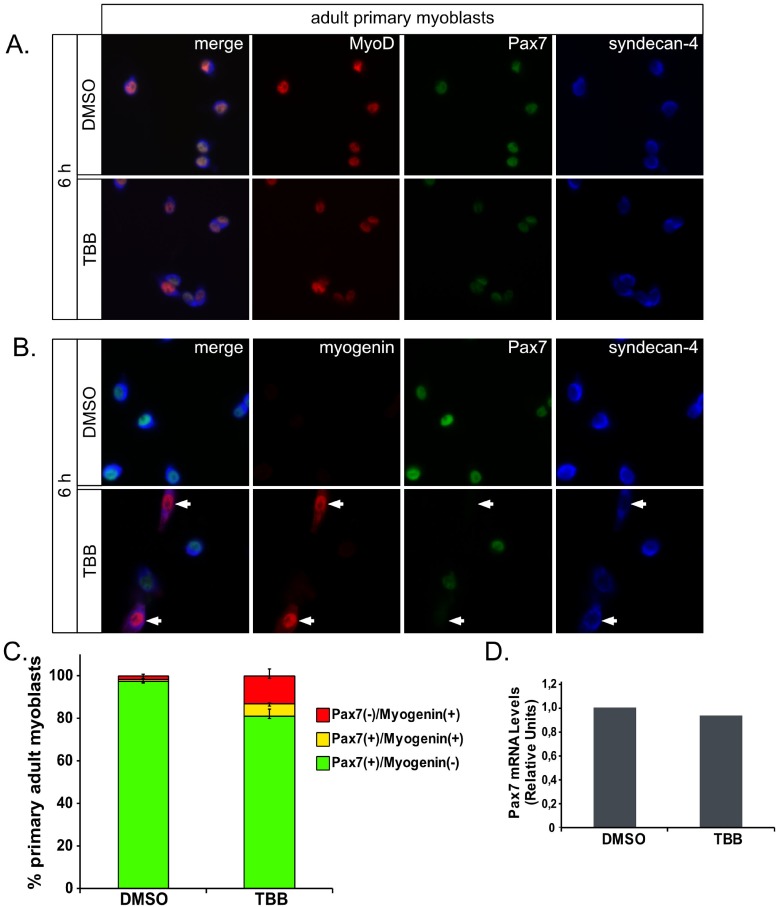
CK2 inhibition in proliferating cells resulted in accelerated expression of differentiation markers.24 h after isolation, mouse primary myoblasts were incubated with 100 μM TBB or DMSO for 6 hours before fixation. Indirect immunofluorescence for Pax7, Syndecan-4 (A, B), MyoD (A), Myogenin (B) was performed as indicated. TBB treatment results in a significant increase in the percentage of cells expressing reduced Pax7 levels, while expressing high levels of myogenin (arrows). (C) Quantification of cell subpopulations present in (B), shows a ~10-fold increase in the percentage of Pax7(-)/ myogenin (+) cells (i.e. differentiating cells) with a concomitant decrease in the percentage of proliferating Pax7(+)/myogenin(-) sub population. mean±SEM, n = 3. (D) qPCR analysis determining relative Pax7 mRNA expression upon CK2 inhibition (sample pool obtained from one experiment performed as in A and B).